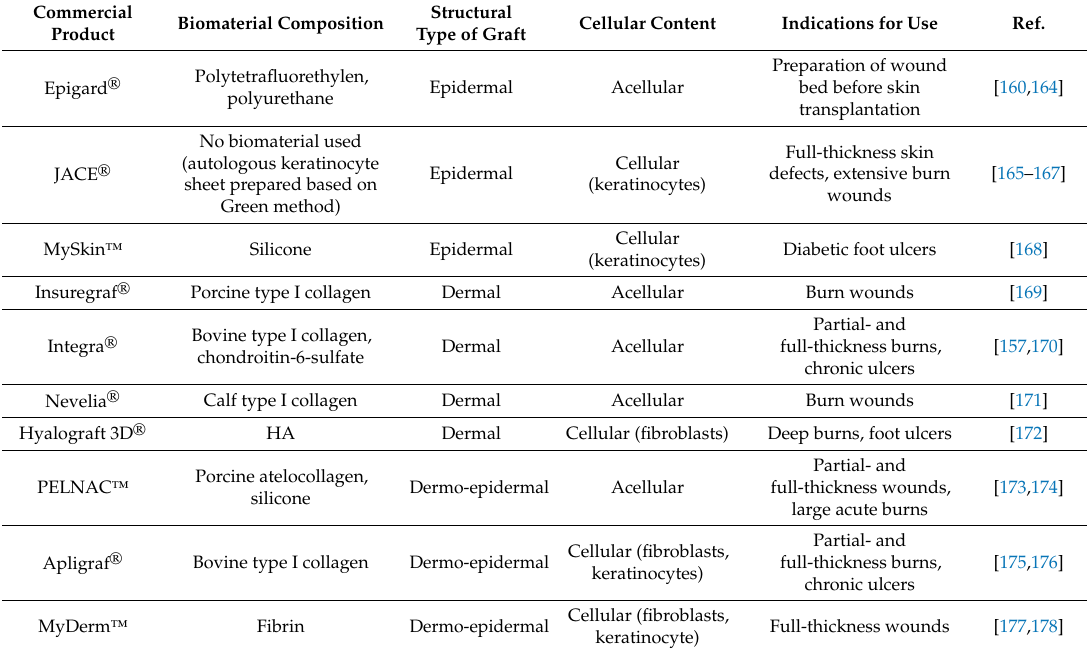
Table 4. Commercially available skin grafts used in the treatment of chronic